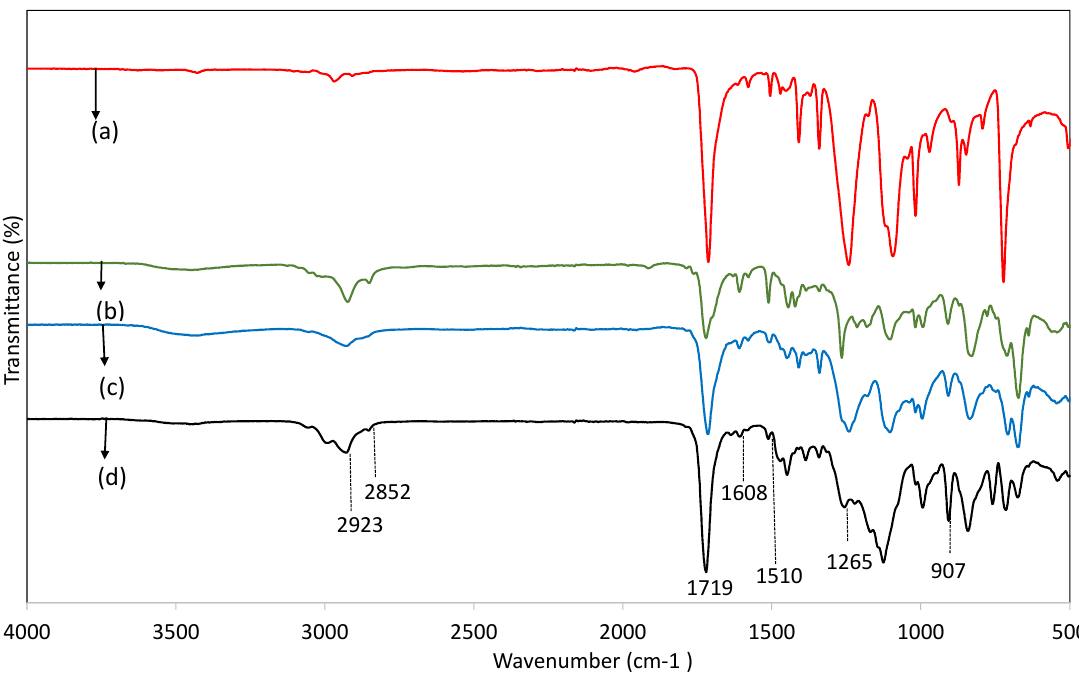
Figure 4. FT-IR spectra of ( a ) non-woven PET; ( b ) GDV75; ( c ) GDV45; and ( d )